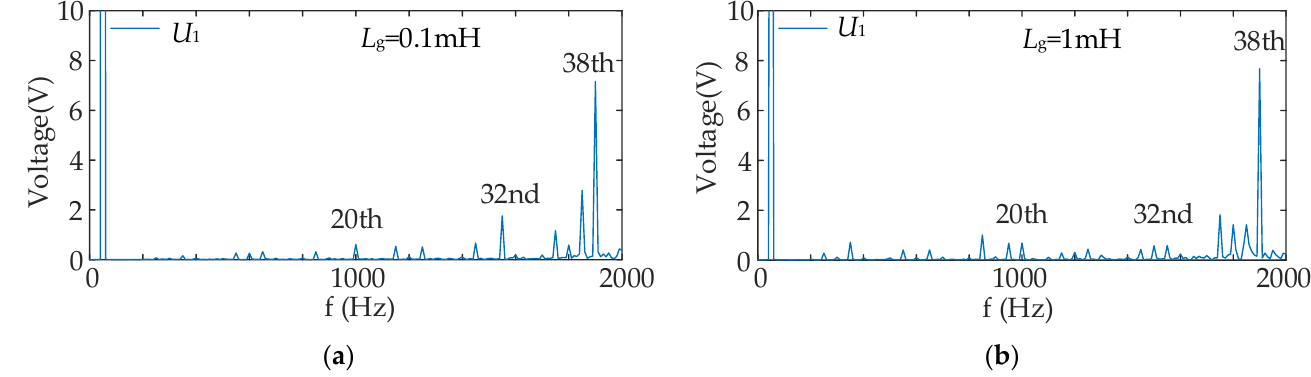
Figure 15. The node voltage spectrum at n = 2: ( a ) U PCC ; ( b ) U 1 . To verify the correctness of the above modal analysis and spectral analysis results, a typical scenario is selected for simulation to verify the effects on the resonance character- istics of the system when the grid impedance L g , the inverter-side inductance L 1 , and the control parameter k r are changed, respectively. The relationship between the fluctuation of the grid impedance L g and the resonance characteristics of the system is verified. Fixing other parameters of the system and keeping the number of inverters connected to the grid at two, test currents of the 20th, 32nd, and 38th harmonics are injected into the system at L g = 0.1 mH and 1 mH, and the corresponding node voltage spectrum changes are shown in Figure 16.